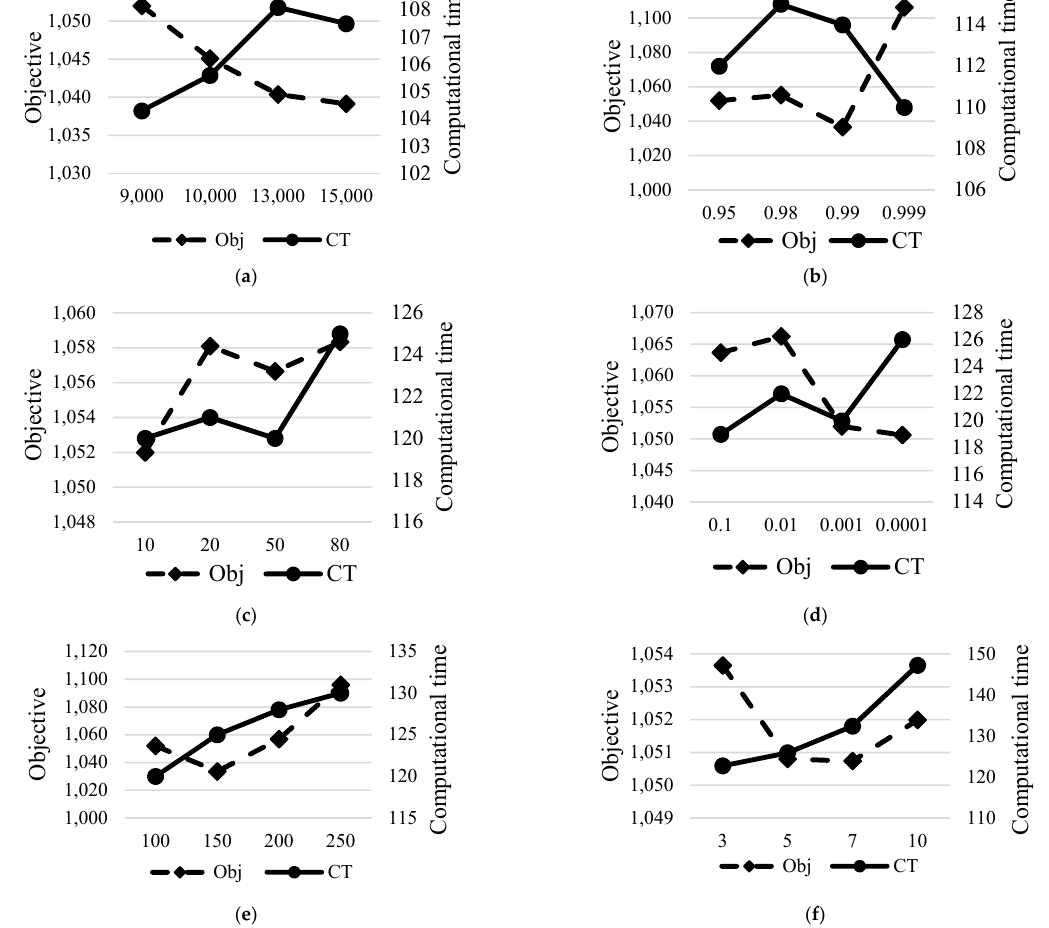
Figure 5. Effect of parameter values on solution quality and computational time. ( a ) I iter ; ( b ) α ; ( c ) T 0 ; ( d ) T F ; ( e ) N Non_Impro ; ( f ) M restart